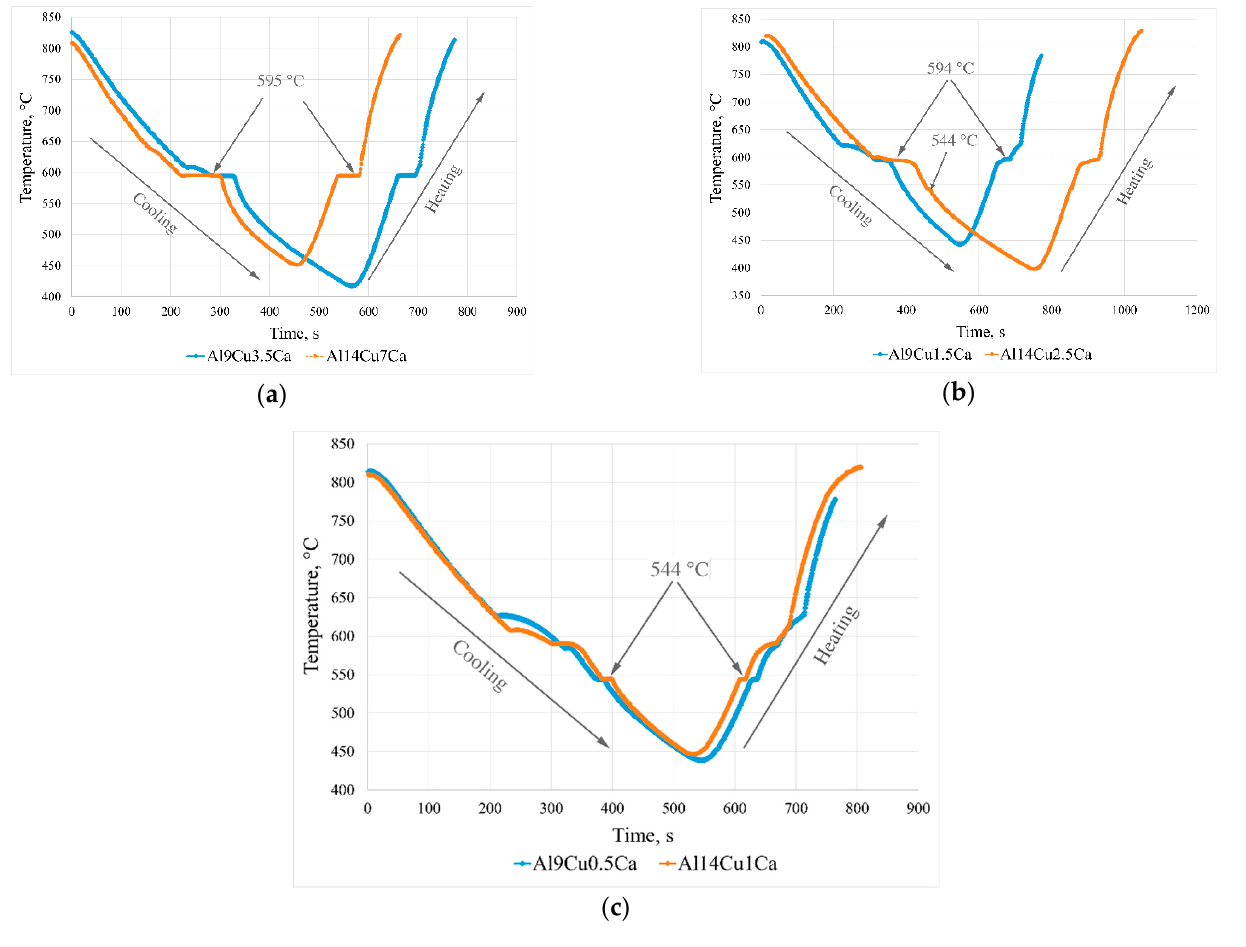
Figure 8. DTA for the alloys: ( a ) Al9Cu3.5Ca and Al14Cu7Ca, ( b ) Al9Cu1.5Ca and Al14Cu2.5Ca, ( c ) Al9Cu0.5Ca and Al14Cu1Ca.